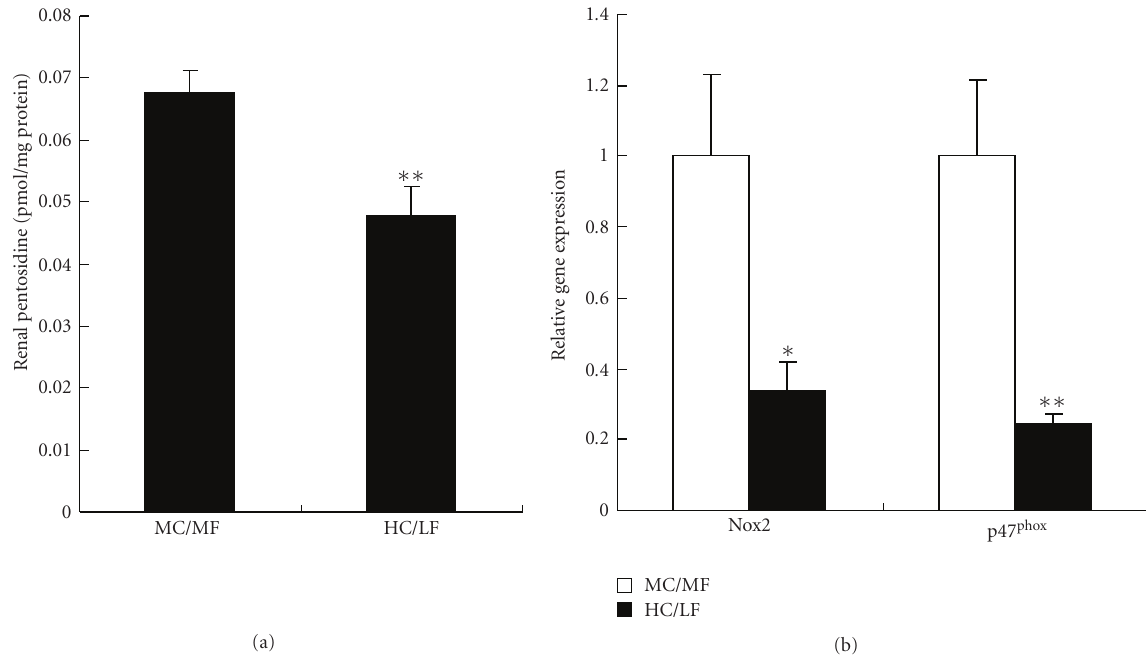
Figure 7: Advanced glycation and oxidative stress in renal tissues. (a) Renal pentosidine content, and (b) gene expressions of Nox2 and p47 phox in MC/MF (white bar) and HC/LF (black bar). ∗ P < . 05, ∗∗ P < .